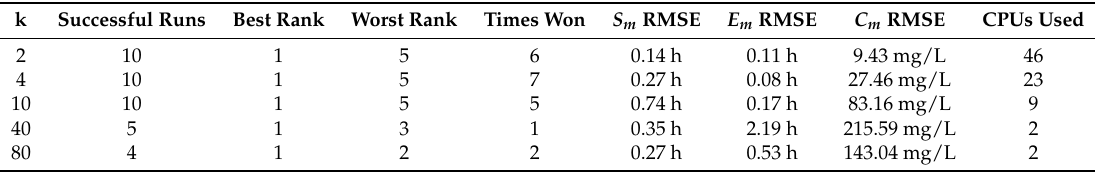
Table 8. Influence of the number of the tournament group size k on the accuracy and efficiency of the